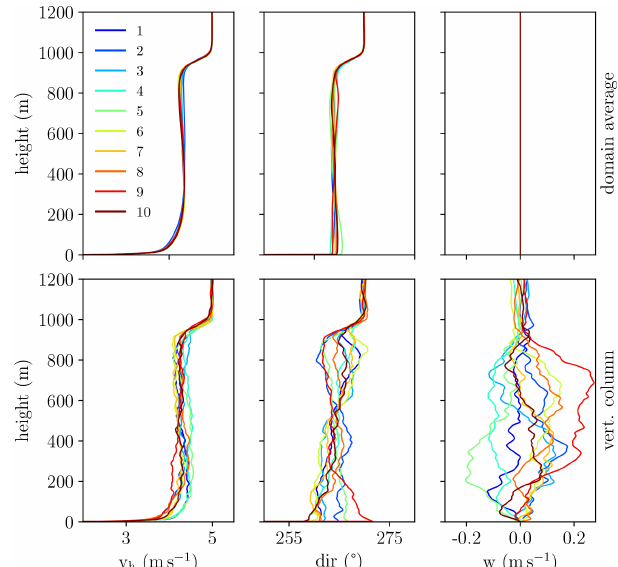
Figure 8. Ensemble case 1: vertical profiles of wind speed, wind direction and vertical wind of every member of the ensemble sim- ulation averaged over a period of 60min. Upper panels show hor- izontally averaged profiles, while lower panels display profiles of the vertical column directly above the lidar location. Straight lines at zero value for the domain average of the vertical wind indicate incompressibility of the flow